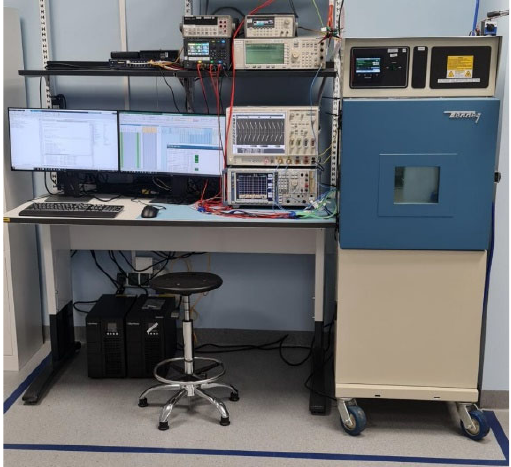
Figure 1. Tenney environmental chamber at a phase ‐ locked loop characterization testbench in the Silicon Creations Laboratory.